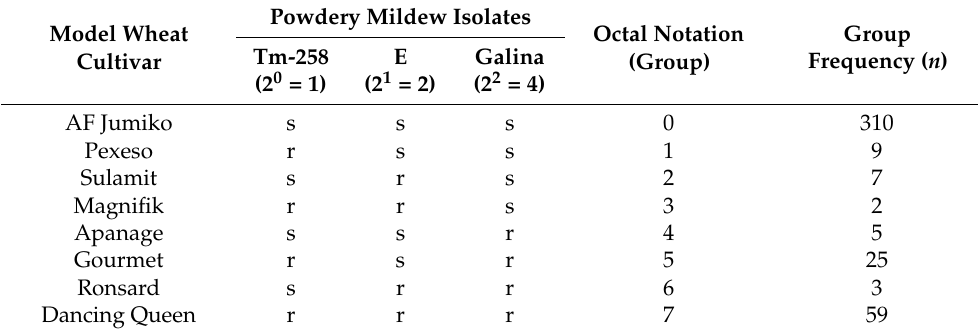
Table 2. Infection response arrays (IRAs) of 420 homogeneous wheats represented by eight model cultivars separately inoculated with three isolates of powdery mildew and octal notation of infection responses to determine their resistance